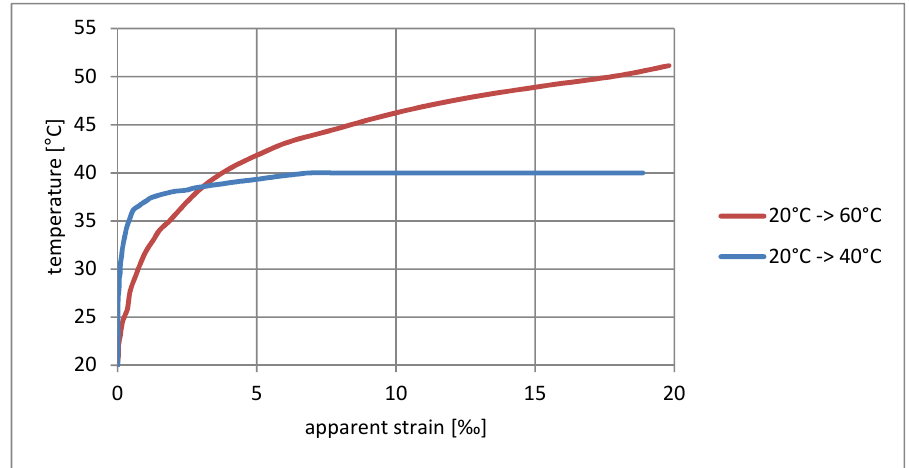
Figure 4. Dependence of apparent strain on rising temperature for the wooden sample.